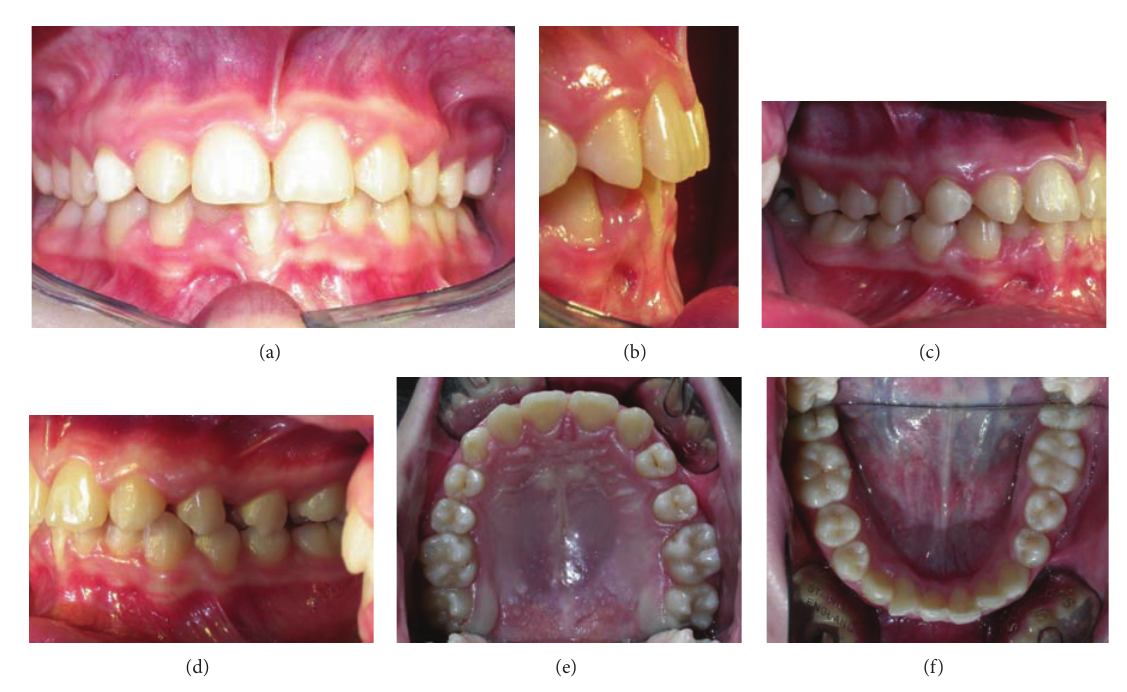
Figure 2: Intraoral photographs before